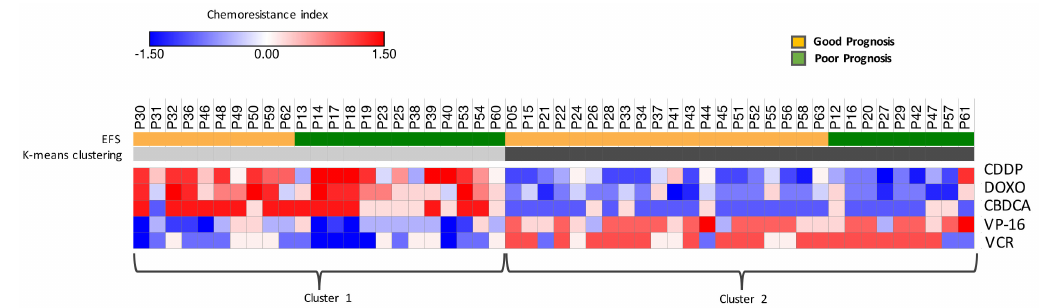
Figure 4. Chemoresistance Index di ff erentiating good and poor responders. K-means clustering built on the CI. The algorithm identifies two groups of patients: cluster 1 includes subjects showing high CI toward CBDCA, CDDP, and DOXO and low CI for VP-16 and VCR; cluster 2 contains patients showing opposite features, with low CI toward CBDCA, CDDP, and DOXO and slightly high CI to VP-16 and VCR. Event-free survival (EFS) defined the response to induction chemotherapy: patients that reported a relapse, a progression, or died are addressed as poor responders. The association between the identified clusters and EFS is significant ( p value < 0.03), showing that the CI is indicative of a poor